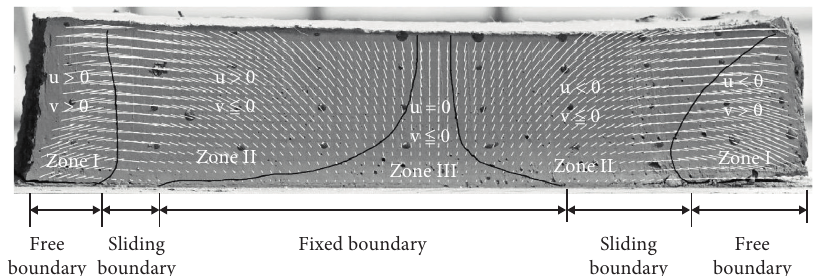
Figure 7: The displacement field of the right block after drying for